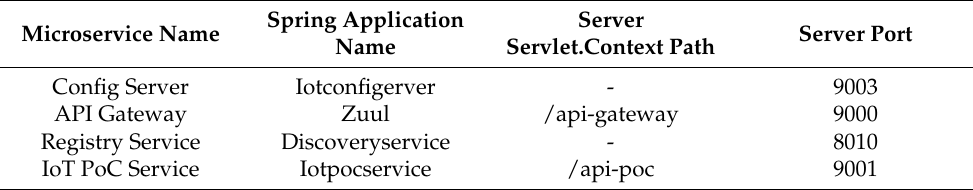
Table 1. Microservices and their overall